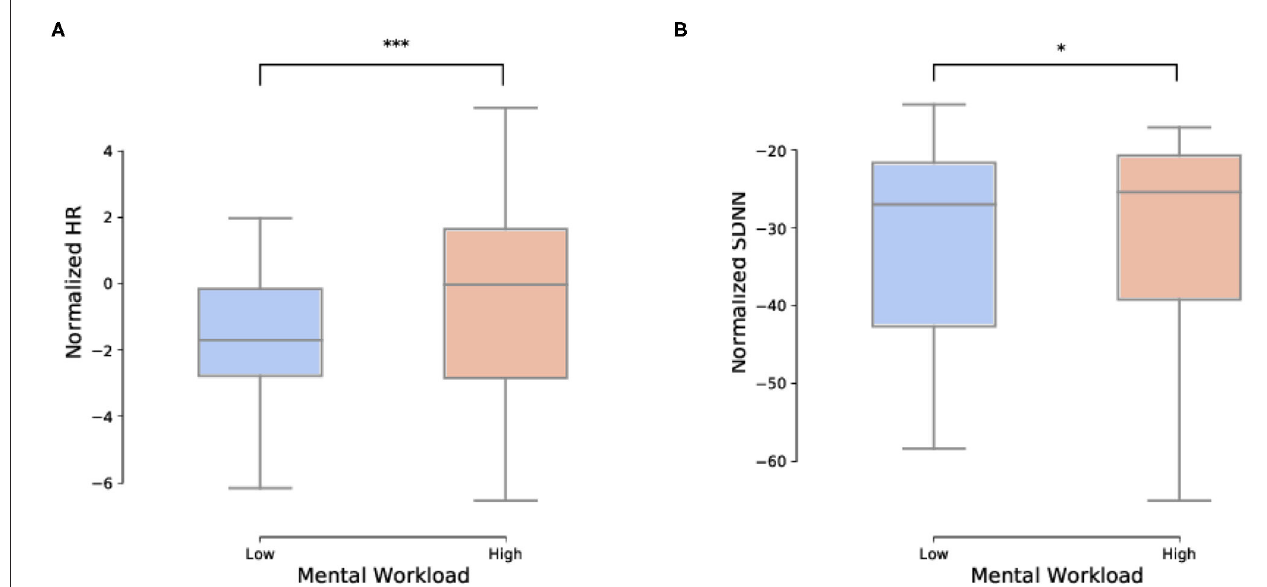
FIGURE 8 | Impact of load on the ECG temporal features. (A) Impact of load on the normalized heart rate (HR) temporal feature ( p < 0.001). (B) Impact of load on the normalized heart rate variability (HRV) ( p < 0.05). Specifically, HRV is the Standard Deviation of the Normal-to-Normal (SDNN) RR-interval. *** p < 0.001 and * p < 0.05.